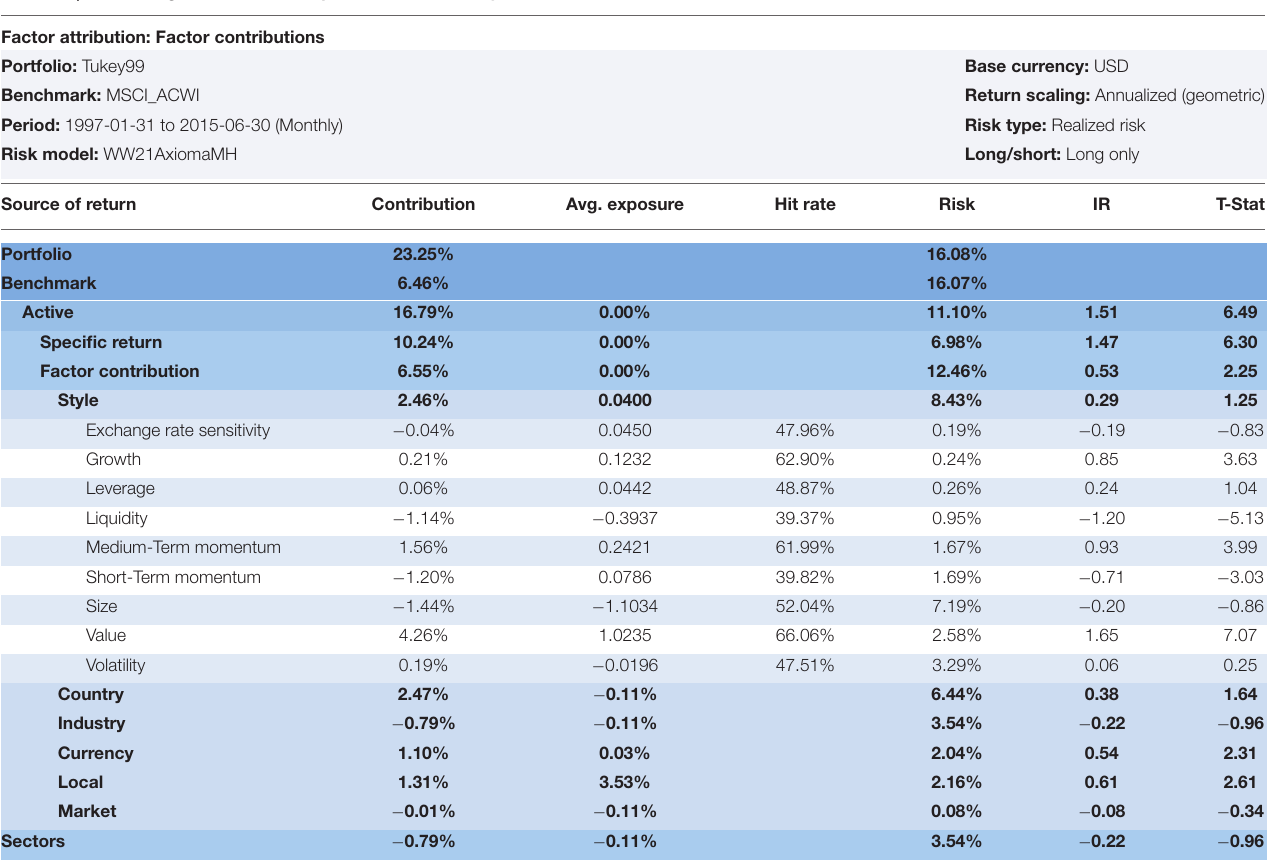
TABLE 8 | Robust regression with MM-procedure with Tukey